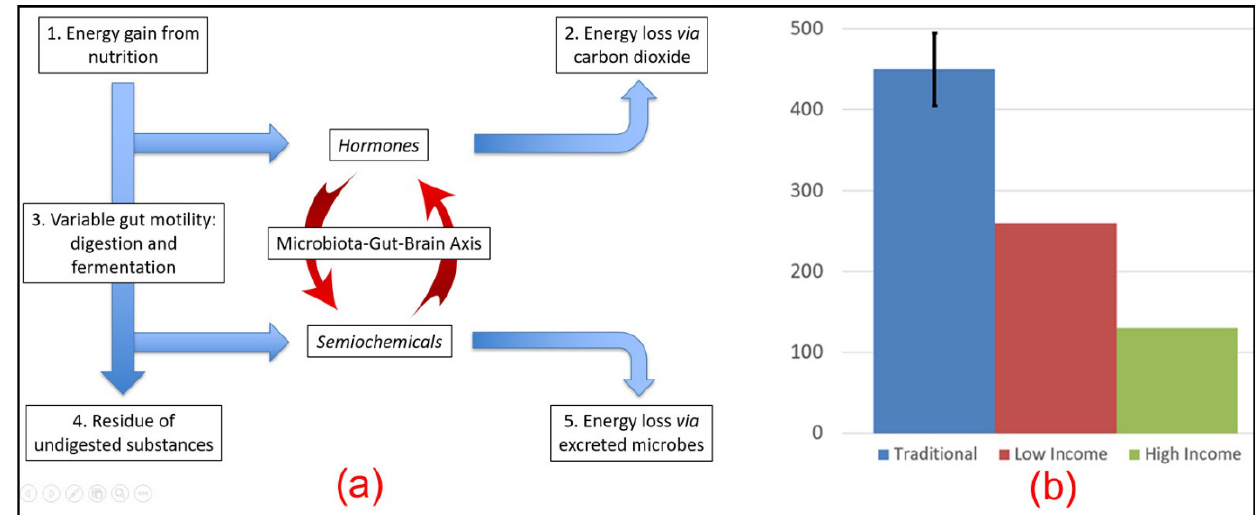
Figure 3. ( a ) The Role of the Adult Microbiota–Gut–Brain Axis in the Partition of Nutrition. Box 1 . Energy is gained by nutrition. As this system is common across the Vertebrata, in principle, it ac- commodates all diets from extreme carnivore to herbivore. Box 2 . The output of carbon dioxide represents the product of metabolism. Many studies are concerned with measuring carbon dioxide output, for example, using double-labelled water [1]. Box 3 . The balance of hormones and semio- chemicals operating through an intact microbiota–gu–brain axis controls gut motility and peristalsis through the gastrointestinal tract. Under normal conditions, a significant amount of nutrition reaches the microbiota, allowing their growth, while at the same time the products of fermentation, short-chain fatty acids, are returned to the body. Box 4 . Faecal output includes a significant amount of indigestible material, for example, cellulose, in addition to sloughed-off cells from the gastroin- testinal tract. Box 5 . Faecal output contains a significant proportion of intestinal microbes. However,